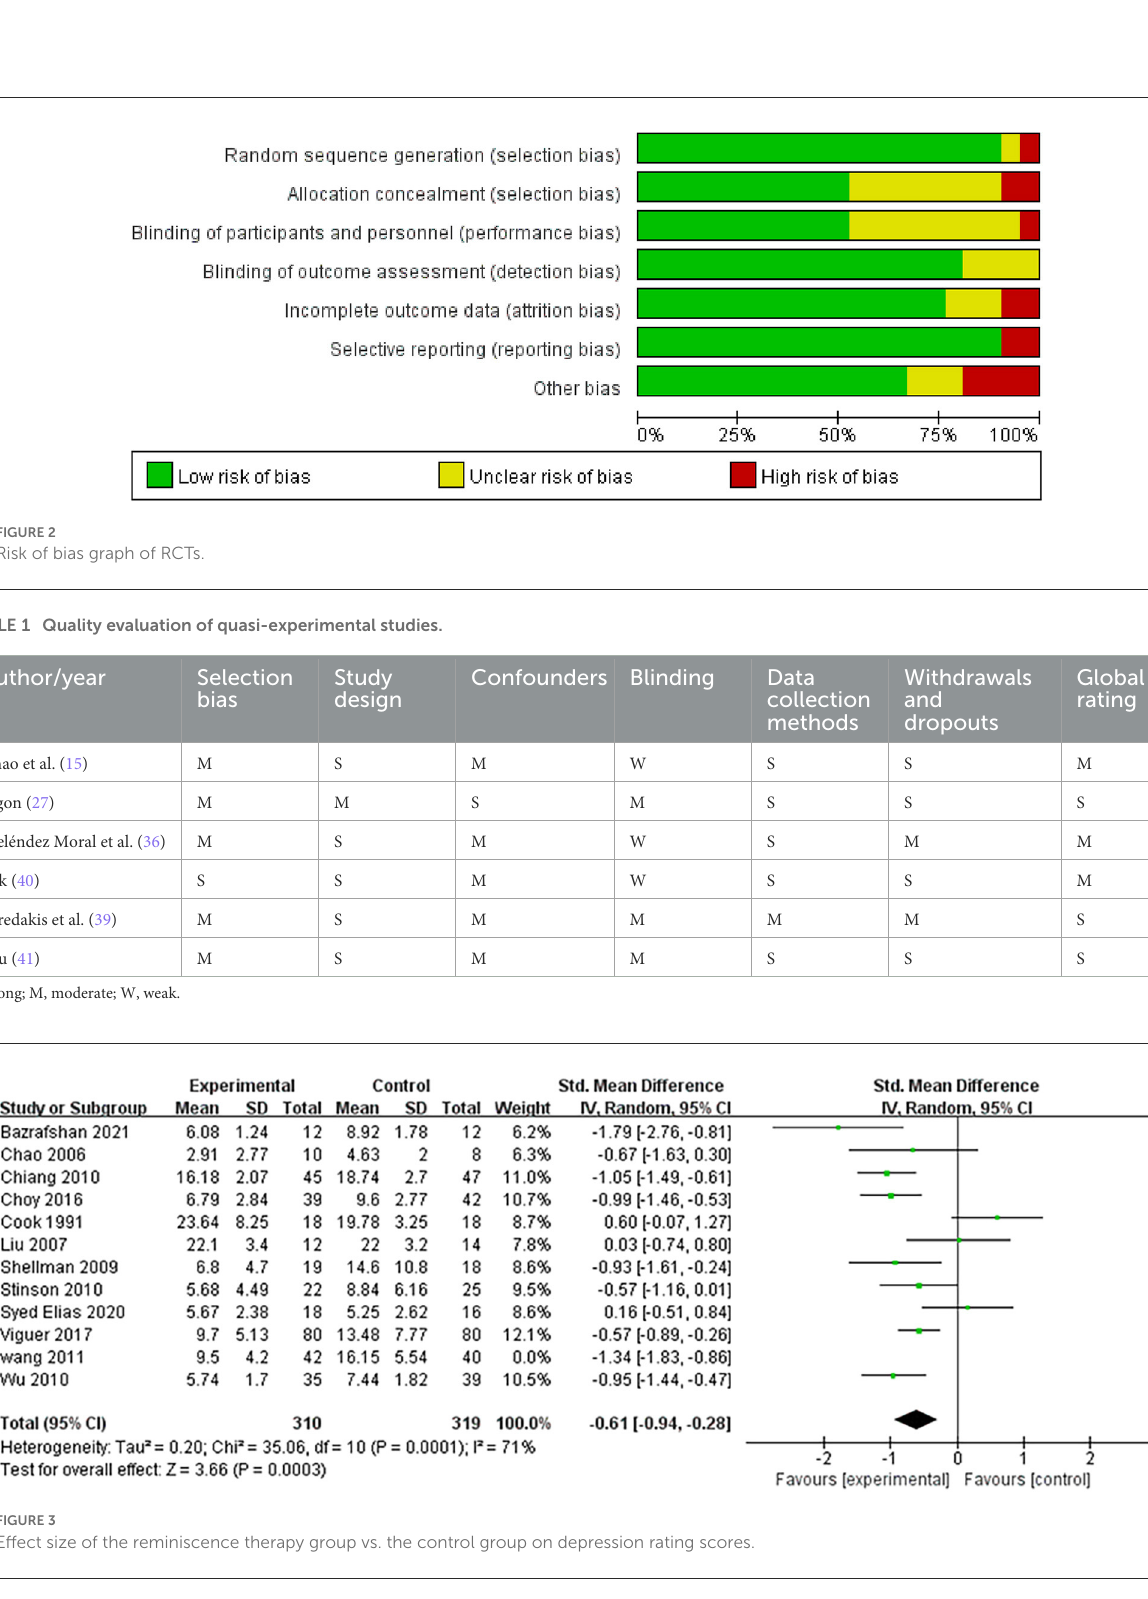
studies reported a significant decrease in the mean score of posttest loneliness. In addition, three studies measured loneliness scores after 3 months of follow-up, two studies (42, 43) found a decrease in loneliness, and the study by Syed Elias et al. (38) found no significant difference (Supplementary Figure